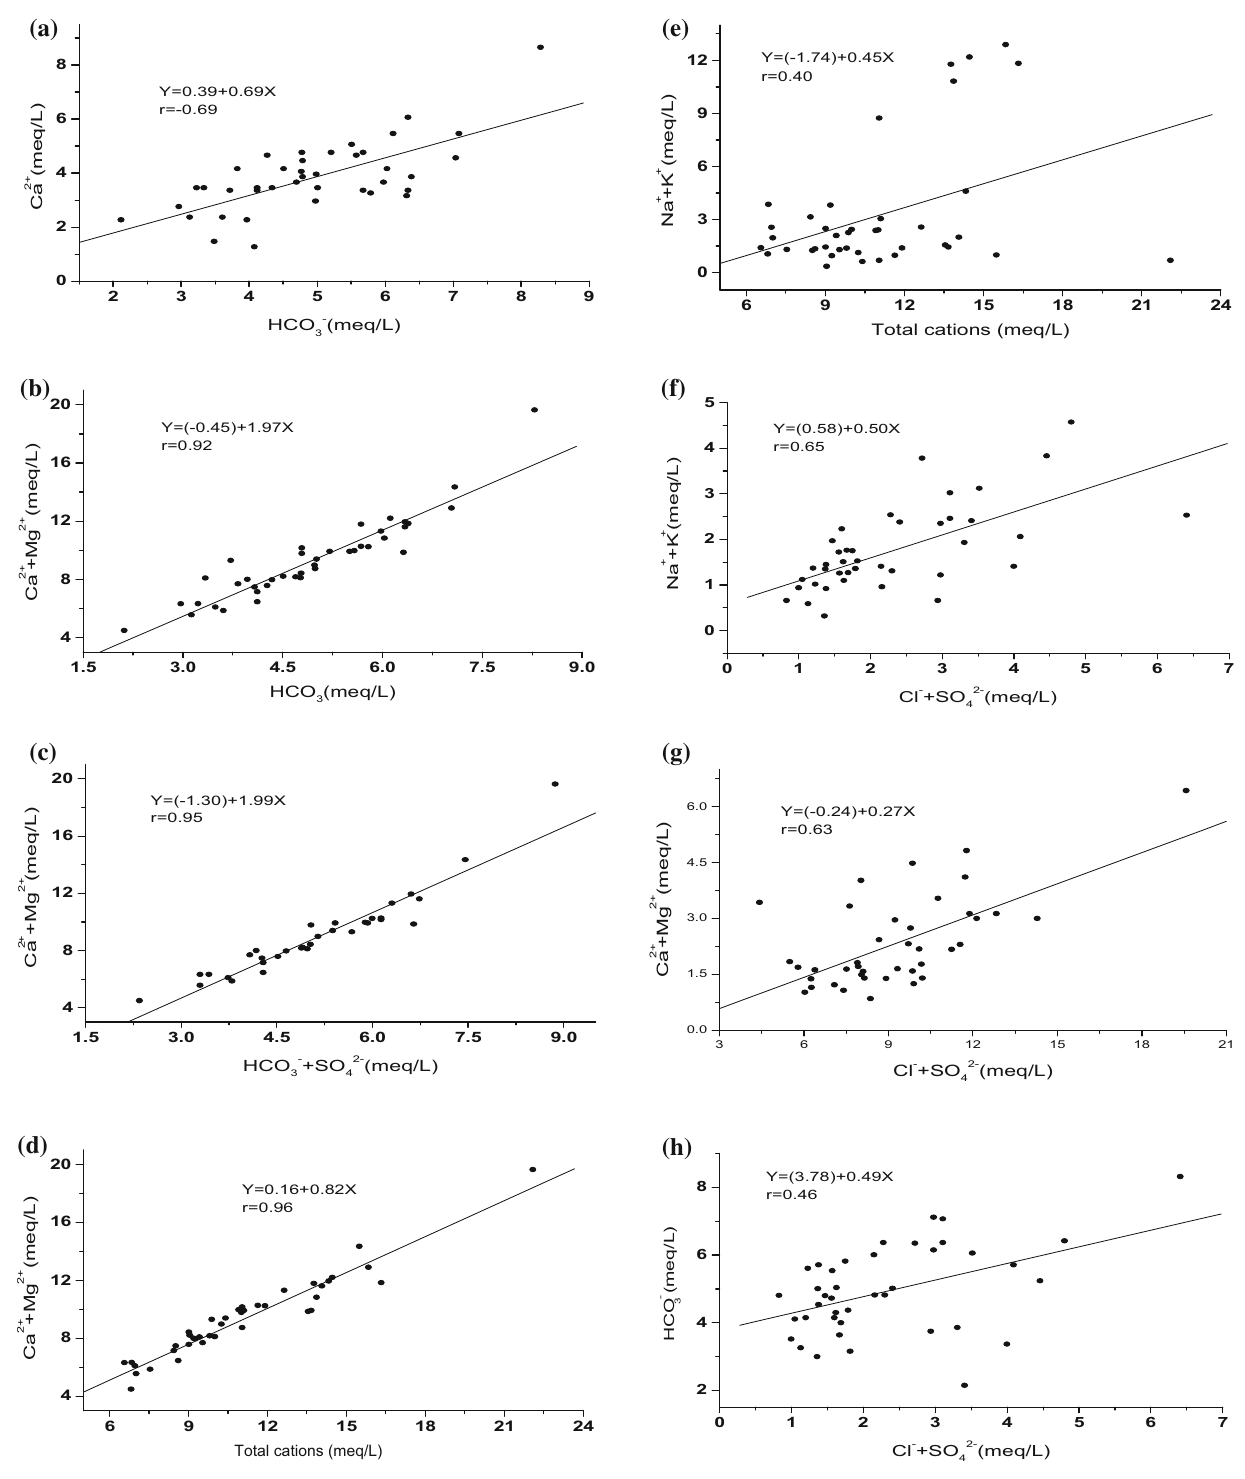
Fig. 8 Scatter plots between. a HCO 3 - vs Ca 2 ? ; b HCO 3 - vs Ca 2 ? ? Mg 2 ? ; c HCO 3 - ? SO 42 - vs Ca 2 ? ? Mg 2 ? ; d total cations vs Ca 2 ? ? Mg 2 ? ; e total cations vs Na ? ? K ? ; f Cl - ? SO 4 2 - vs Na ? ? K - ; g Cl - ? SO 4 2 - vs Ca 2 ? ? Mg 2 ? ; h Cl - ? SO 4 2 - vs HCO 3